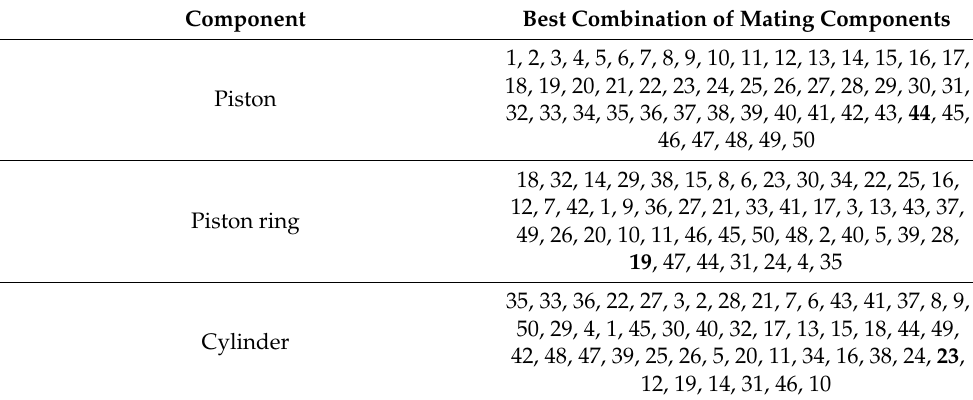
Table 12. Selective assembly scheme corresponding components number